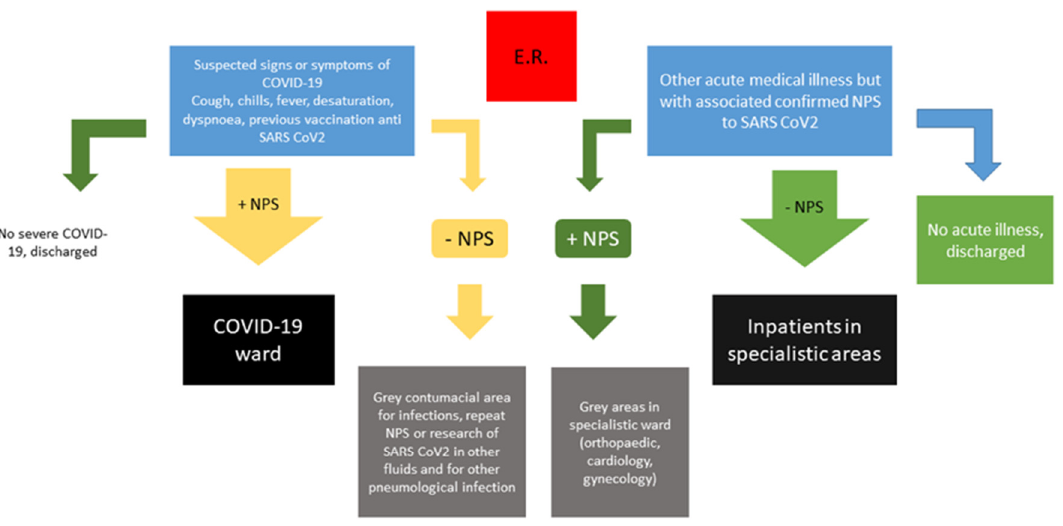
Figure 1. Updated flow chart for managing patients with confirmed or suspected infection by SARS-CoV-2, updated for summer/autumn